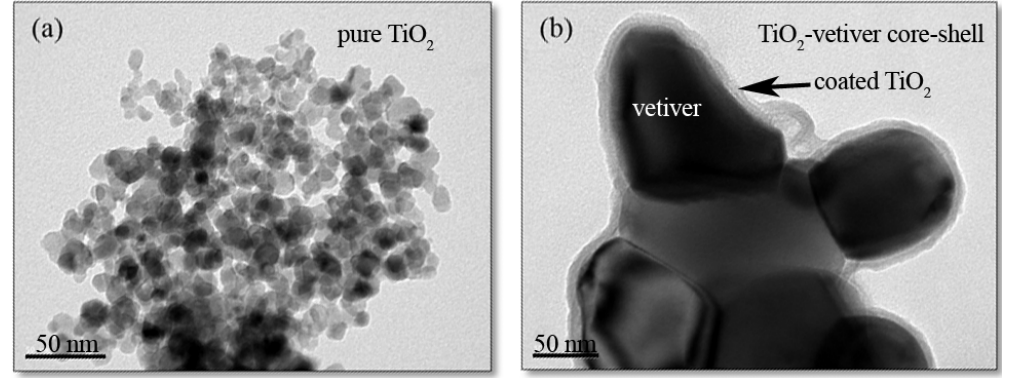
Figure 4. TEM images of ( a ) pure TiO 2 ; and ( b ) TiO 2 ‐ vetiver core–shell.